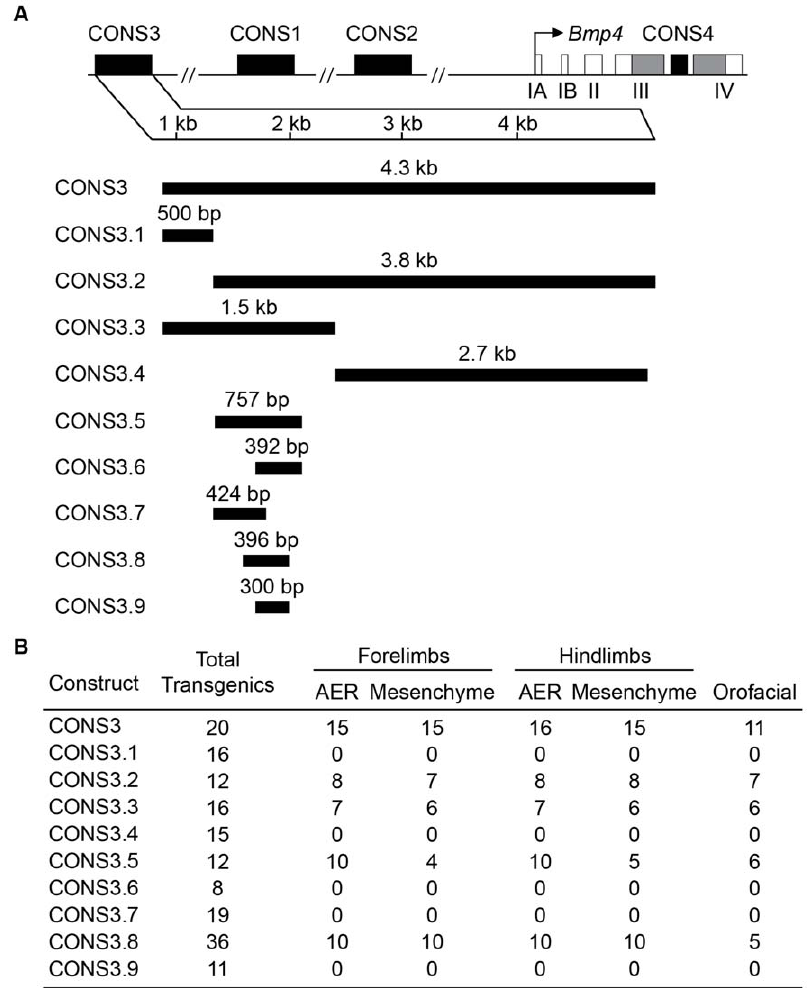
Figure 4. Deletion analysis of the Bmp4 enhancer CONS3. ( A ) Schematic of the four regions (CONS1-4; black boxes), each containing multiple human-mouse sequence conservation blocks, tested in a transient transgenic mouse reporter assay in the same reporter shown in Figure 2. The CONS3 enhancer was systemically narrowed down to 758 bp region, CONS3.5, which contains the Fugu-Mouse upstream conservation block, and then to a minimal 396 bp minimal enhancer. ( B ) The number of E11.5 transgenic mouse embryos showing endogenous Bmp4 orofacial and limb expression (in the AER and mesenchyme region of fore- and hindlimbs) is reported over the total number of transgenic embryos analyzed (No. Stained/No.